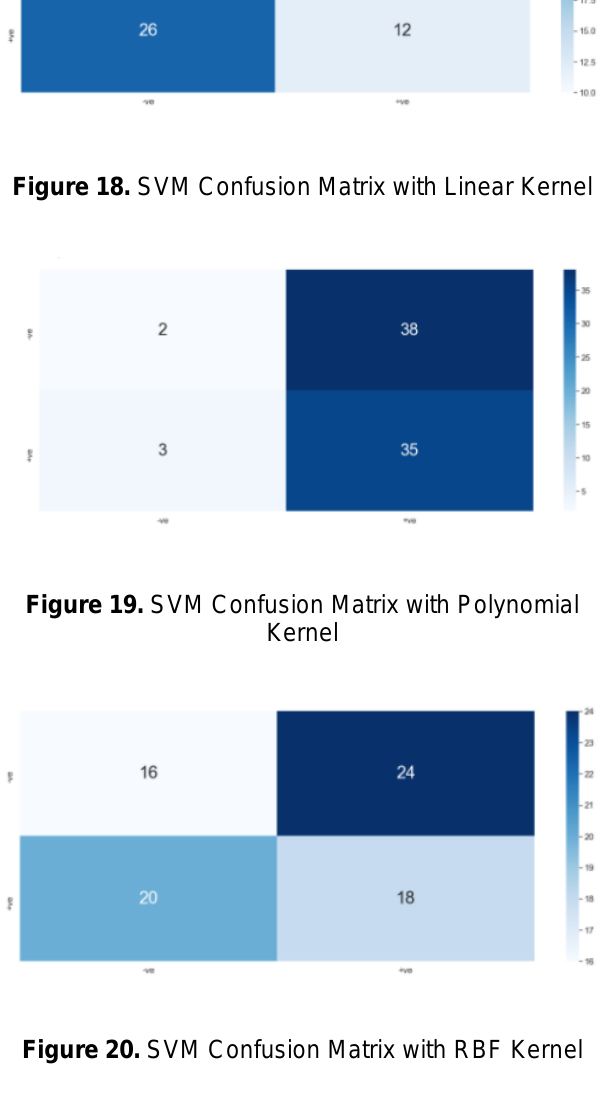
Figure 17. Classes of Outcome (Target Variable)